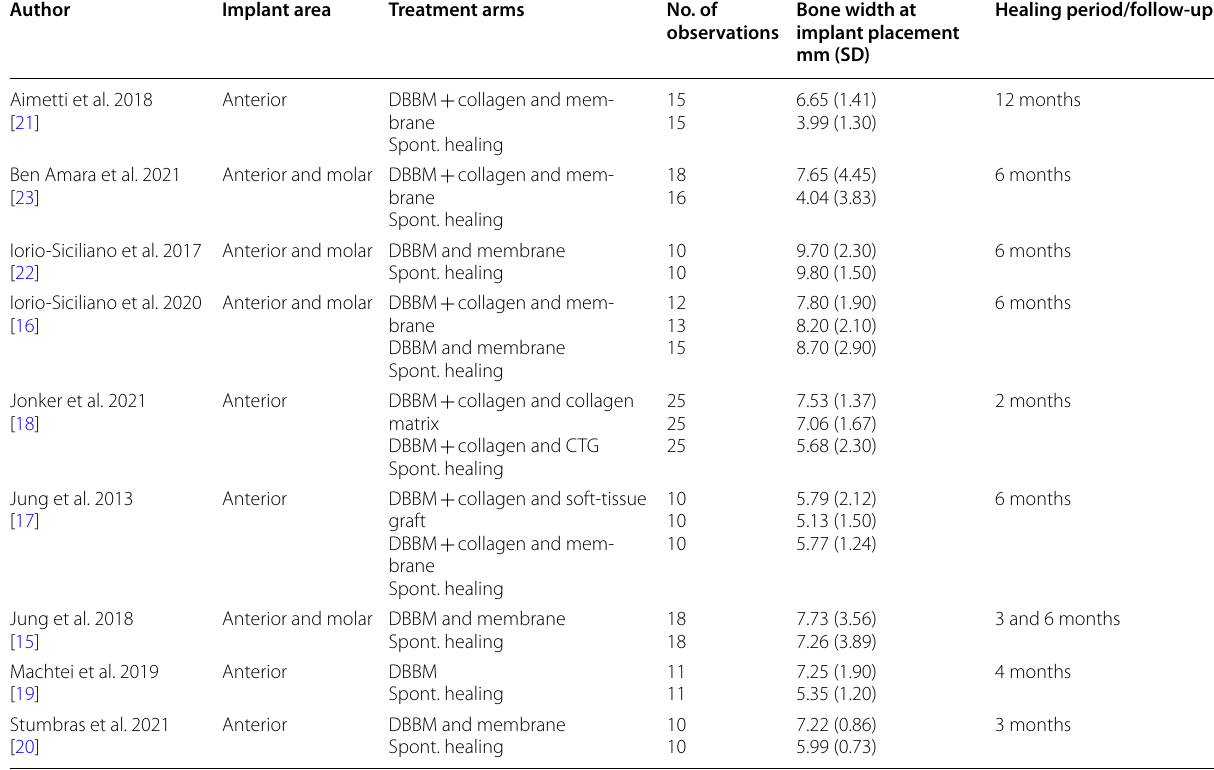
DBBM deproteinized bovine bone mineral; CTG =